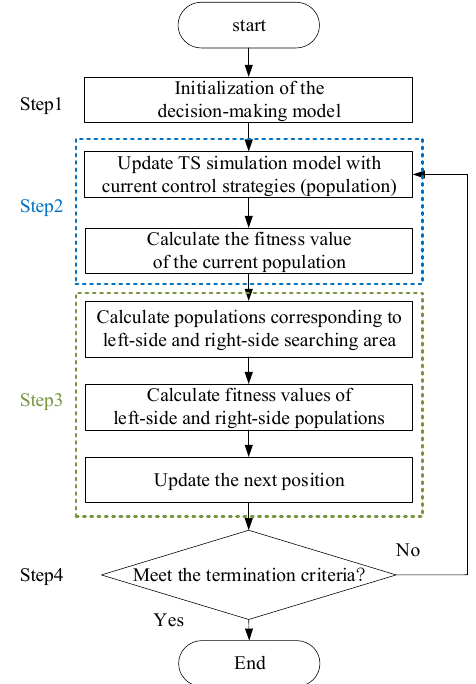
Figure 4. Flowchart of the decision-making procedure.